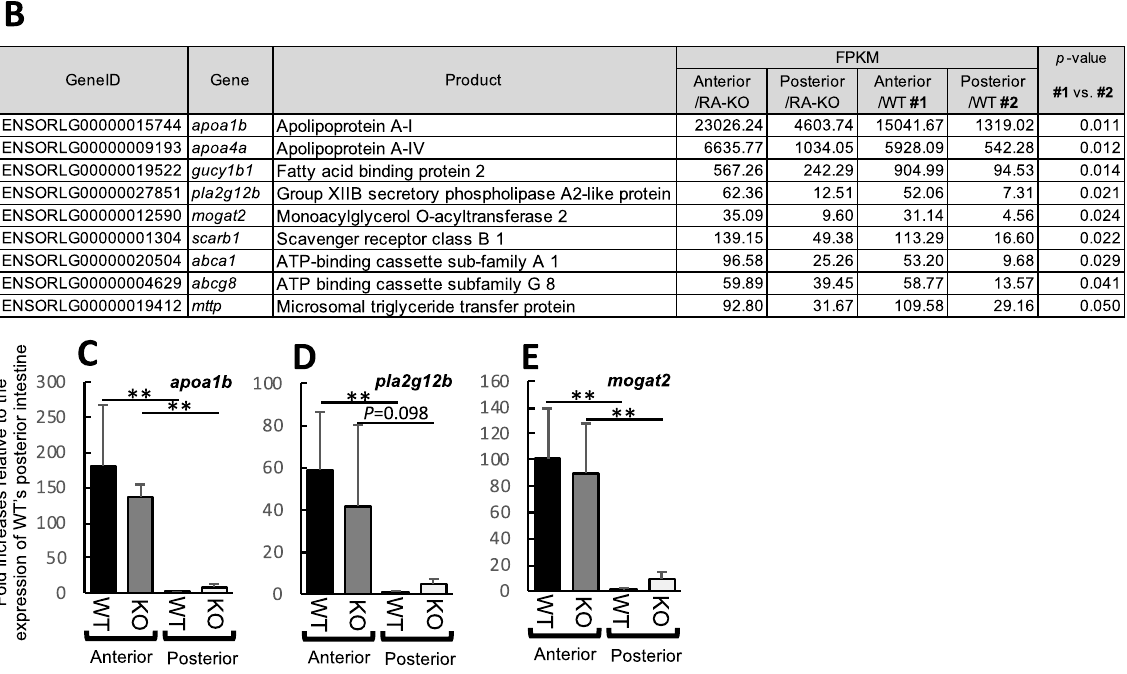
Figure 5. Pathway maps of notable differentially expressed gene (DEG) hits in the anterior intestines, as determined using the Kyoto Encyclopedia of Genes and Genomes (KEGG) database. ( A ) Medaka anterior intestines showed enhanced expression of genes related to the “fat digestion and absorption” (KEGG map04975) pathway, as observed in the small intestines of mammals. ( B ) Nine DEGs were significantly localized to the anterior intestine, and their expression patterns were observed in IL-17RA1-KO medaka. ( C–E ) Of the nine DEGs, the expression levels of apolipoprotein A-I ( apoa1b ), group XII B secretory phospholipase A2 ( pla2g12b ), and monoacylglycerol O-acyltransferase 2 ( mogat2 ) were confirmed by quantitative polymerase chain reaction (qPCR) analysis. ** P < 0.01, * P < 0.05 (Student’s t -test or Welch t -test in R version 3.5.3). The data shown were obtained in one experiment with five individual fish (n =